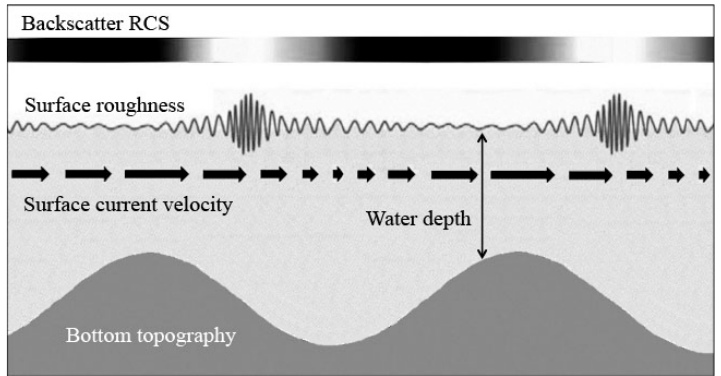
Figure 23. Illustrating the dependence of the backscatter radar cross section (RCS) through the surface roughness changes caused by varying surface currents.